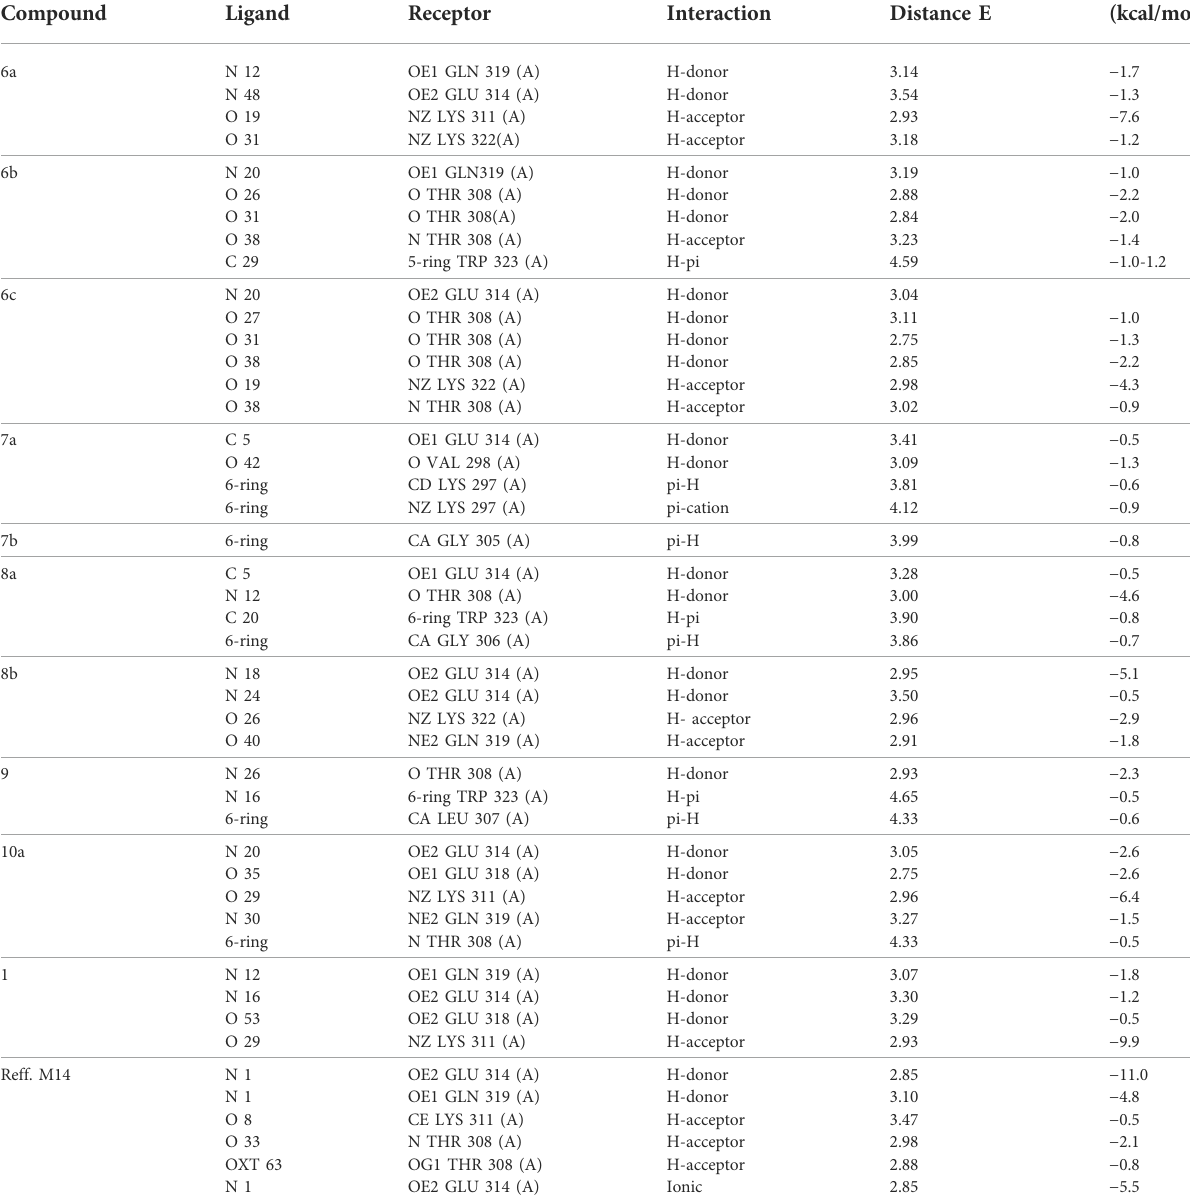
TABLE 7 Docking interaction of all compounds with 2OPZ “ melanoma cancer protein. ” Compound Ligand Receptor